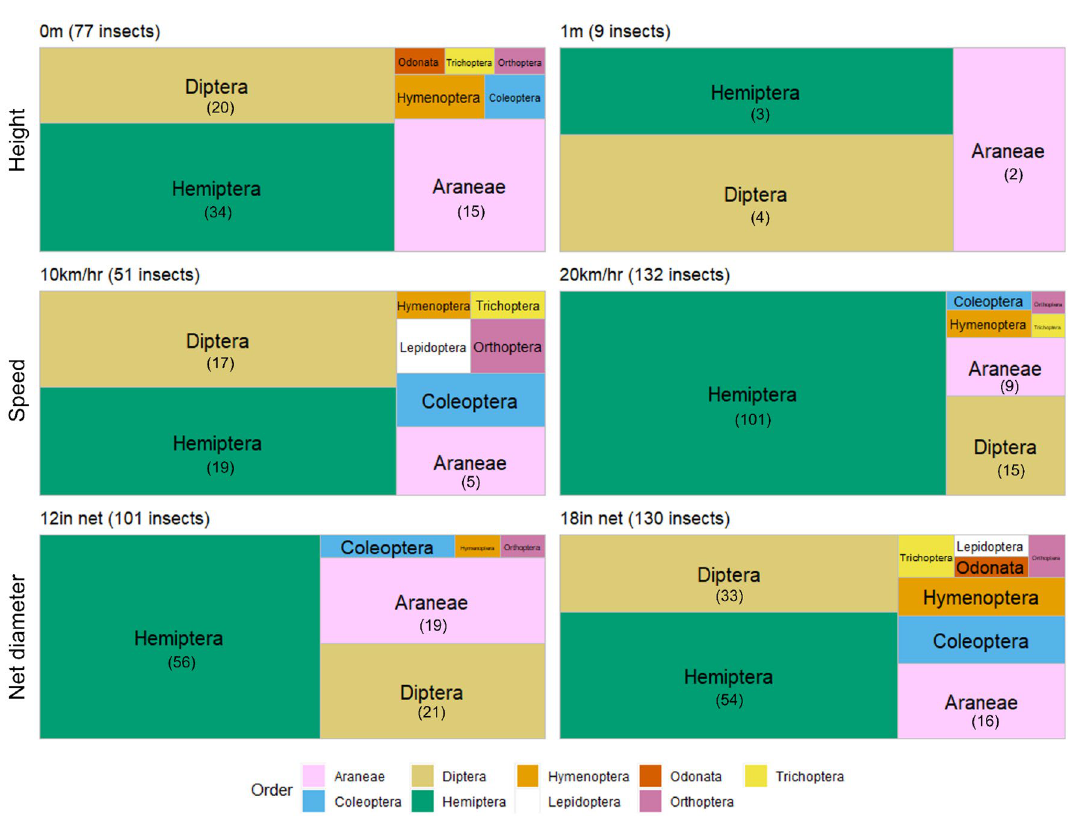
Figure 3. Treemap of insect sample composition collected by different drone settings; height (0 m vs. 1 m), speed (10 km/hr vs. 20 km/hr), and net diameter (12in vs. 18in). Default settings were 0 m, 10 km/hr, and 12 in. Boxes represent total proportion of the insect order compared to total insects caught using ta particular method. The total number of individuals collected of the top 3 orders collected by each setting are marked below the